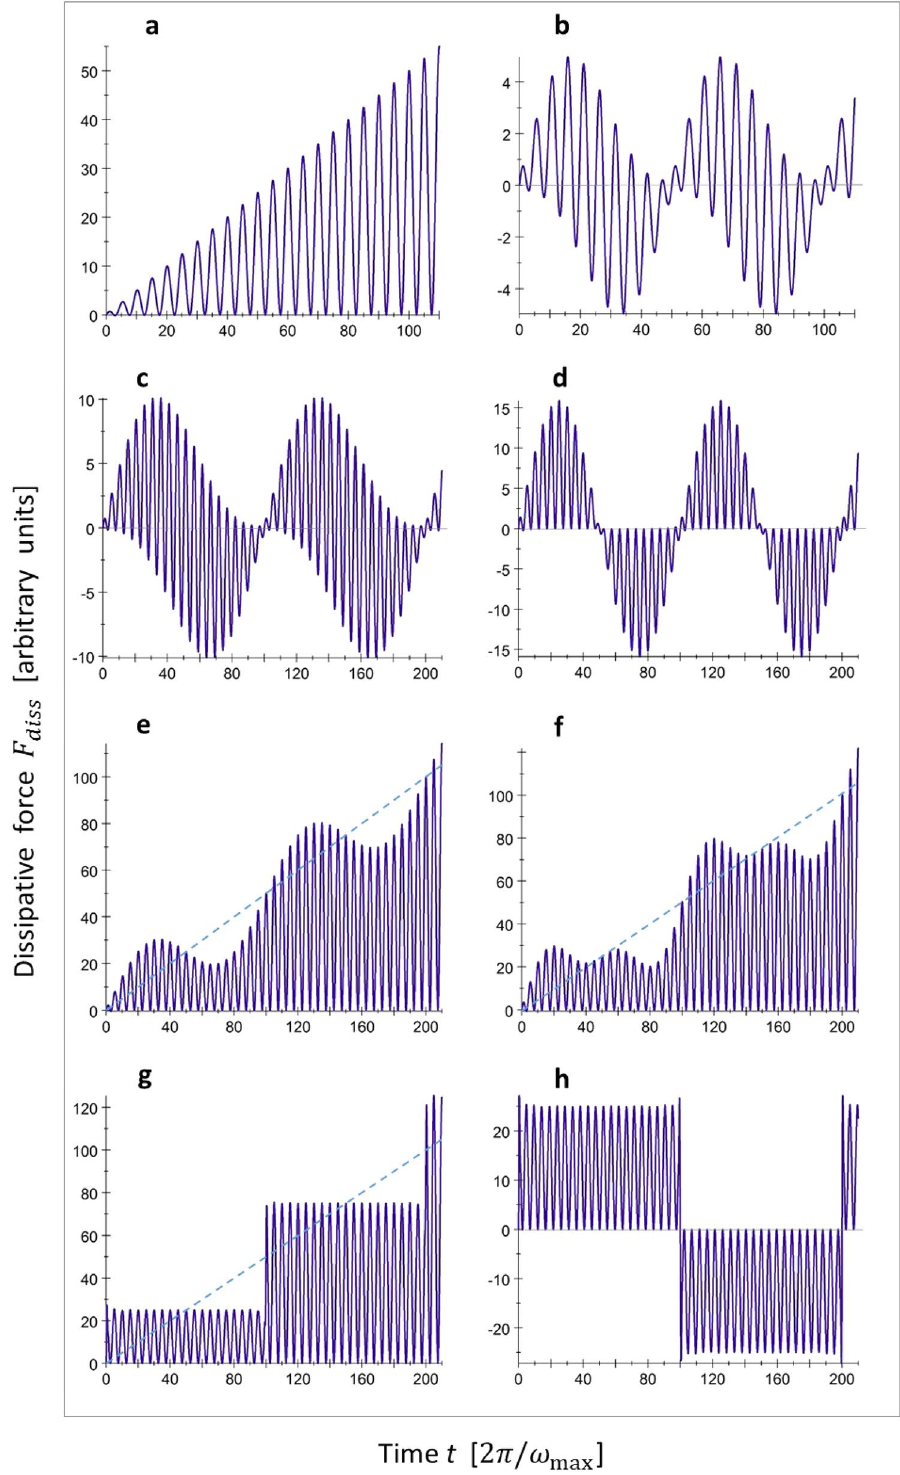
Figure 3. Single- and few-phonon contributions to the dissipative force as a function of time, calculated for a finite system with 100 equidistant phonon frequencies. In ( a–g ) the particle velocity is again set to 10% of the velocity of sound, so that the washboard frequency is 0.10 ω max . ( a–c ) Demonstrate individual phonon contributions for specific frequencies: 0.10 ω max (resonance, ( a )), 0.08 ω max ( b ) and 0.09 ω max ( c ). ( d–f ) Correspond to sums of several frequency contributions: 0.09 ω max and 0.11 ω max ( d ), 0.09 ω max , 0.10 ω max and 0.11 ω max ( e ), 0.08 ω max , 0.09 ω max , 0.10 ω max , 0.11 ω max and 0.12 ω max ( f ). As a continuation of this series, ( g ) shows the sum over all 100 frequency contributions (which formally correspond to the spectrum of a Debye solid of 100 × 100 × 100 atoms). ( h ) Is similar to ( g ), but with the washboard frequency shifted away from resonance to 2 π v / a = 0.105 ω max . Blue dotted lines are guides to the eye and indicate the growing force amplitude of the resonant contribution, seen in ( a